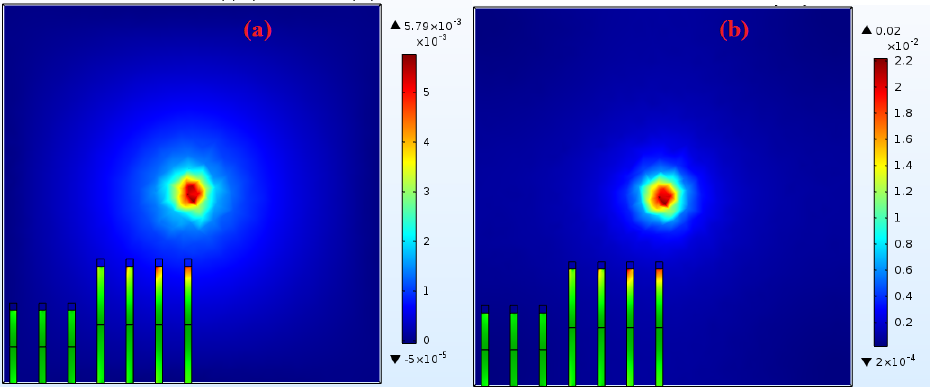
Figure 15. The profile of air pressure and velocity when the air is directed on the sensors from a microhole with R = 12 µm and vertical distance of 400 µm from the surface of the chip. (a): pressure profile (Pa) , (b): velocity profile (m/s) .